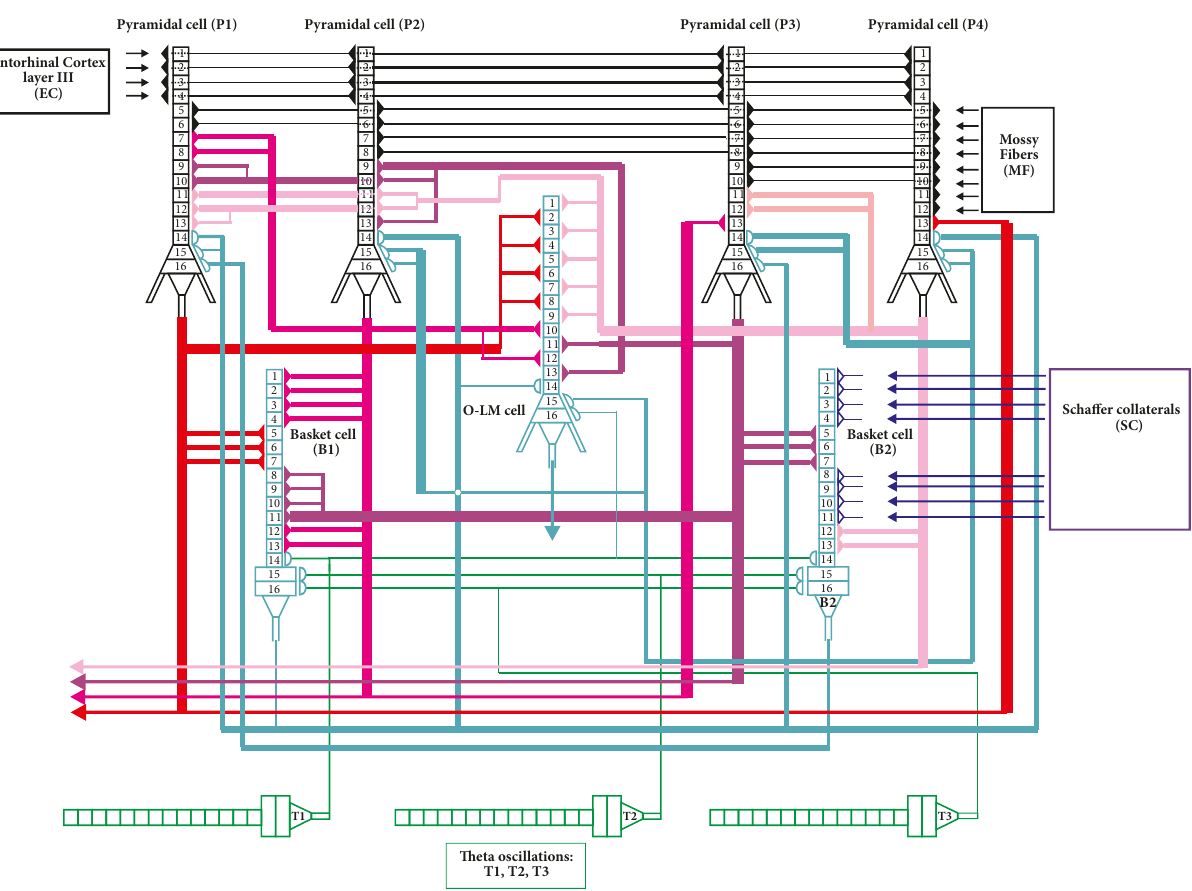
Figure 1: Hippocampal formation CA1 microcircuit showing pyramidal, basket, and OL-M cells. CA1 network: P1, P2, P3, P4: pyramidal cells; B1, B2: basket cells; and OL-M cell. Each CA1 pyramidal cell received distal apical excitation from the layer 3 entorhinalcortex (EC) and mid-dendritic excitation from Mossy Fibers